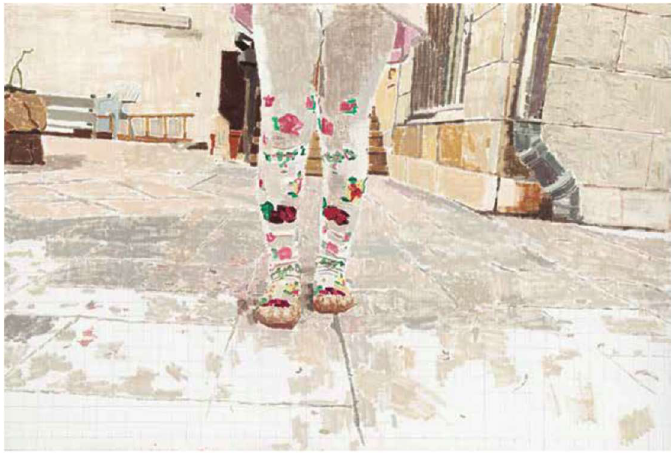
Figure 16. Fatma Shanan, Untitled , 2016, oil on canvas, 100 × 150 cm.